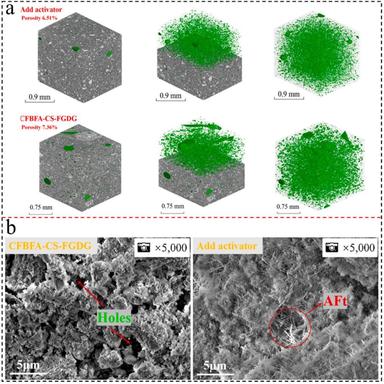
Scanning analysis of microscopic morphology (a: CT scanning of composite system, b: SEM analysis of composite system).